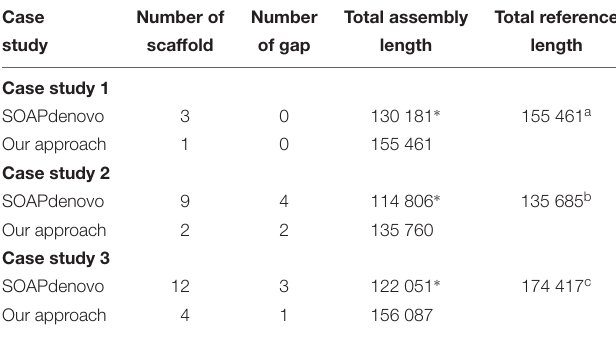
TABLE 3 | Comparison of the SOAPdenovo assembly and de novo assembly derived after stages 4 and 5 from the proposed